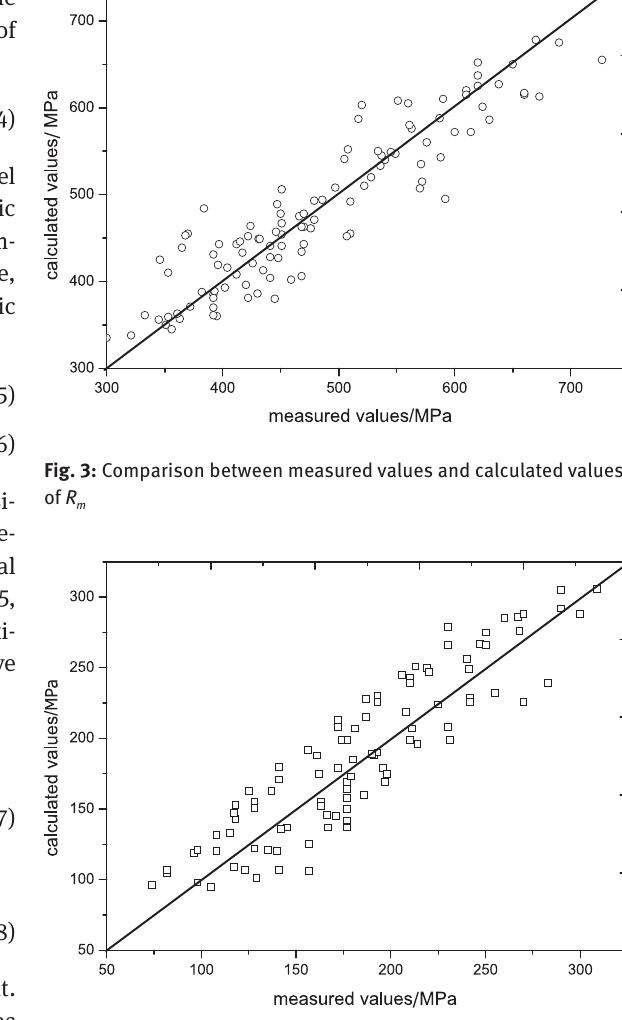
Fig. 4: Comparison between measured values and calculated values of R P